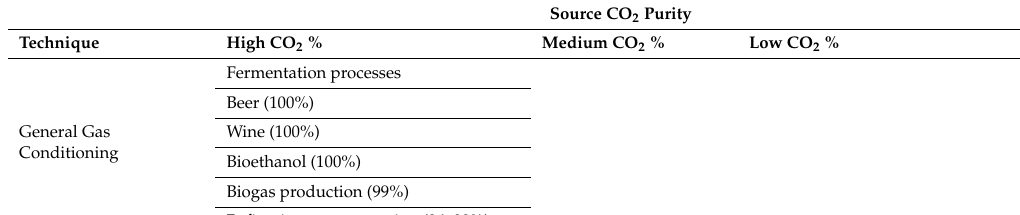
Table 1. Matching carbon sources and carbon separation technologies (with information from [9,11,12,